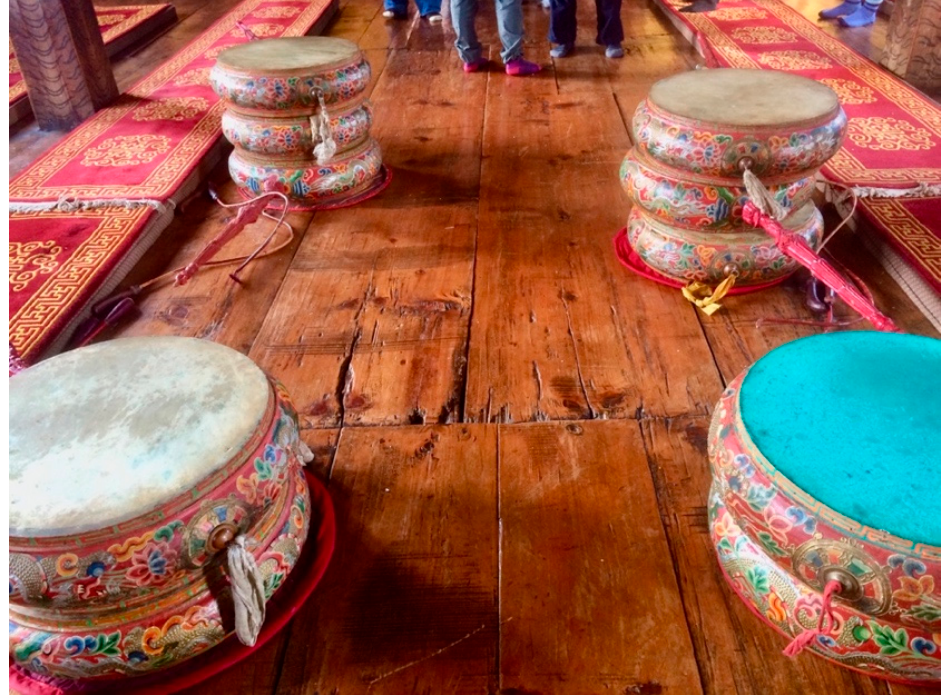
Figure 6. Ceremonial drums at rest inside a hall at Gangteng Monastery. Image by Shin Yu Pai.